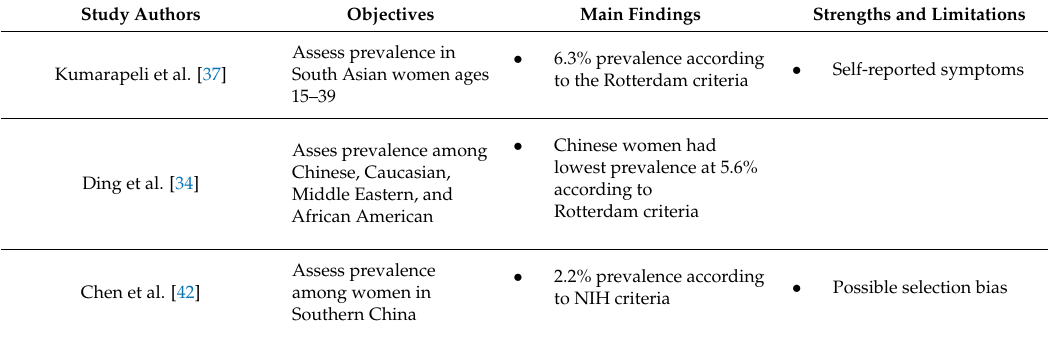
Table 4. Summary of studies on international